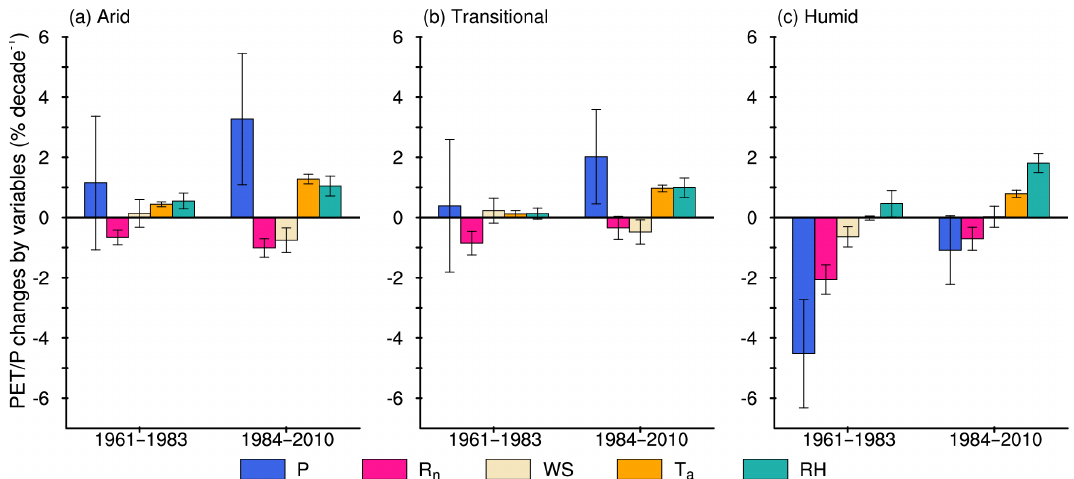
Figure 7. Relative influences (% decade − 1 ) of five climate parameters averaged over the three hydroclimate regimes: arid (a) , transitional (b) , and humid (c) . The influences are computed for two analysis periods: 1961–1983 and 1984–2010. Blue, pink, beige, orange, and cyan bars represent the respective influences of P , R n , WS, T a , and RH. Error bars represent confidence intervals at the 95% confidence level.